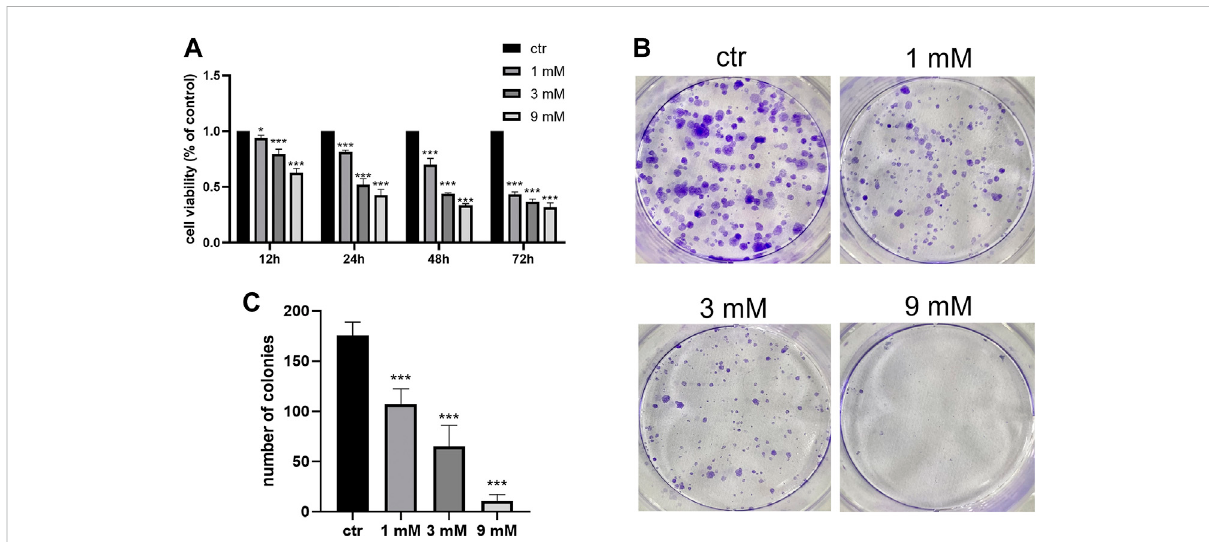
FIGURE 1 Metformin inhibited the proliferation of Daoy cells. (A) CCK-8 assay was used to investigate the effects of metformin treatment on cell viability ( n = 6). (B,C) Colony formation assay was used to detected the effects of metformin treatment on clone ability of cells ( n = 3). Data are presented as the mean ± SD, t-tests were used to determine the signi fi cance. * p < 0.05; *** p < 0.001 compared with the control group.